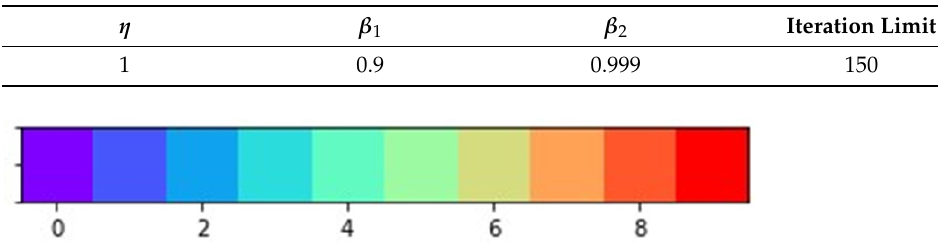
Figure 5. Colors and the corresponding digits.